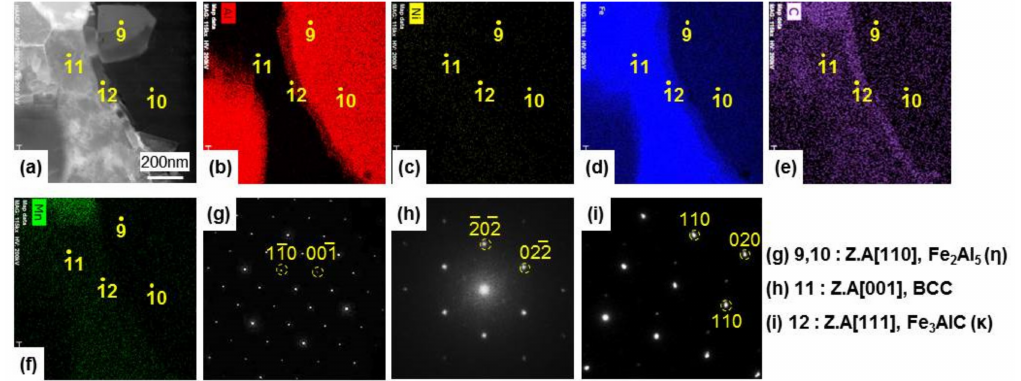
Figure 7. ( a ) Microstructure observed for the area marked as (cid:3) in Figure 5e; ( b – f ) Results of the EDS analysis: ( b ) Al, ( c ) Ni, ( d ) Fe, ( e ) C, and ( f ) Mn; ( g – i ) Characteristic SAED patterns and their key diagrams taken from the phases denoted as 9–12 in ( a ): ( g ) 9 and 10, ( h ) 11, and ( i ) 12 (Zone axis: